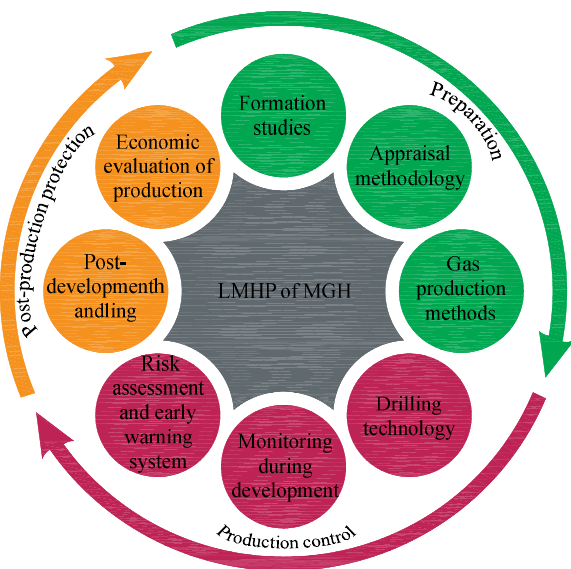
Figure 9. Lifecycle management schematic.